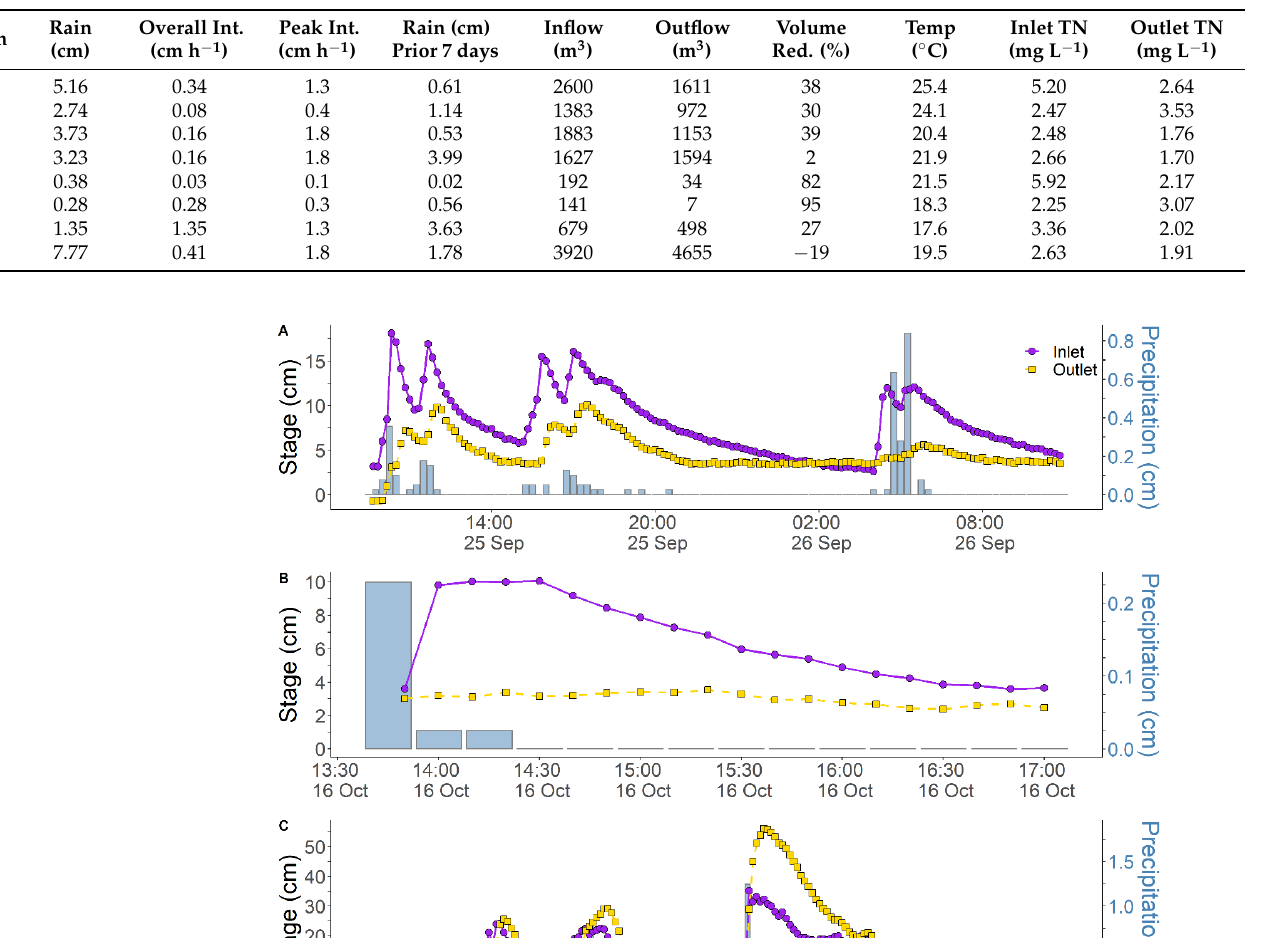
Table 2. Hydrological characteristics of 8 storm events sampled for water quality.